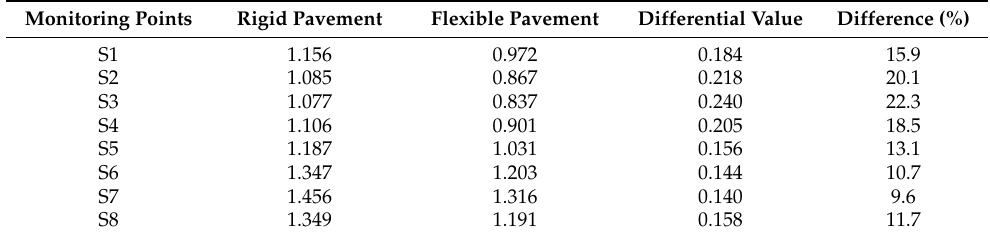
Figure 12. ( a ) A vertical displacement curve of the monitoring point; ( b ) shear stress cloud diagram of tunnel center section. Table 3. Peak displacement values of the monitoring